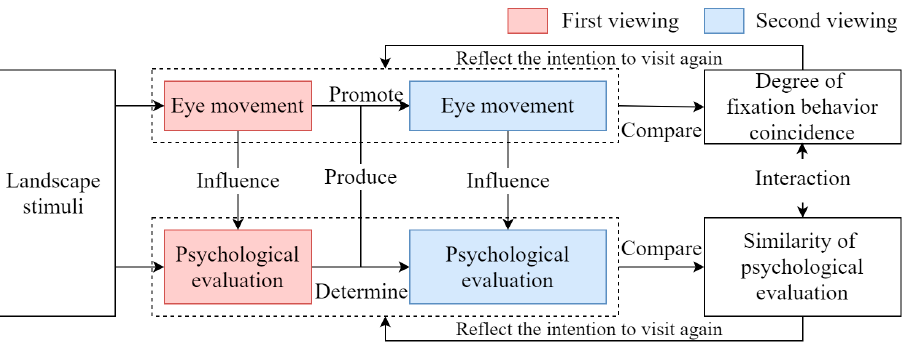
Figure 11. The relationship between visual behavior and landscape preference when repeatedly viewing. The graphics software is Draw.io v13.9.9. This figure was created by the